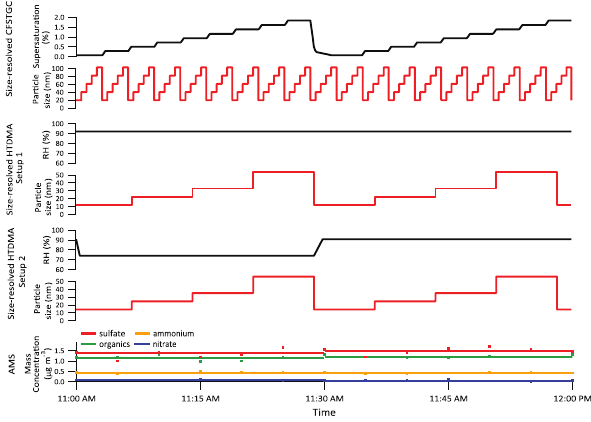
Fig. 2. Example of the operation schedule for CFSTGC, HTDMA, and AMS measurements. A schematic of the HTDMA measure- ment schedules for data collected up to 1 May and after 3 May are indicated as Setup 1 and Setup 2, respectively. An example of ac- tual data collected by AMS is represented by circles, while lines represent 30 minute averages used for this